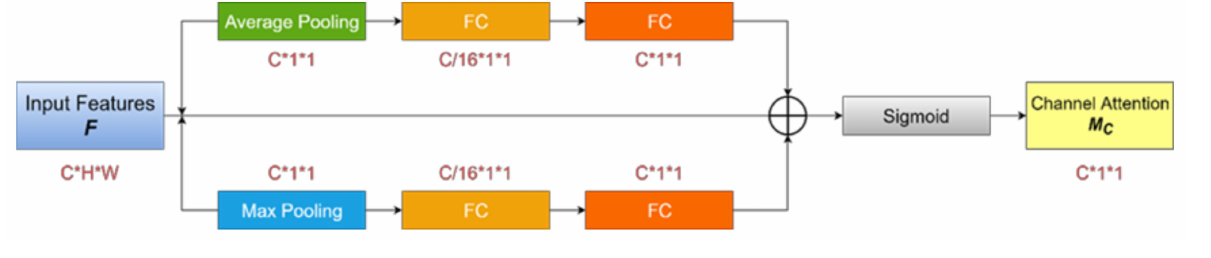
Figure 3. Basic framework structure of the channel attention module.